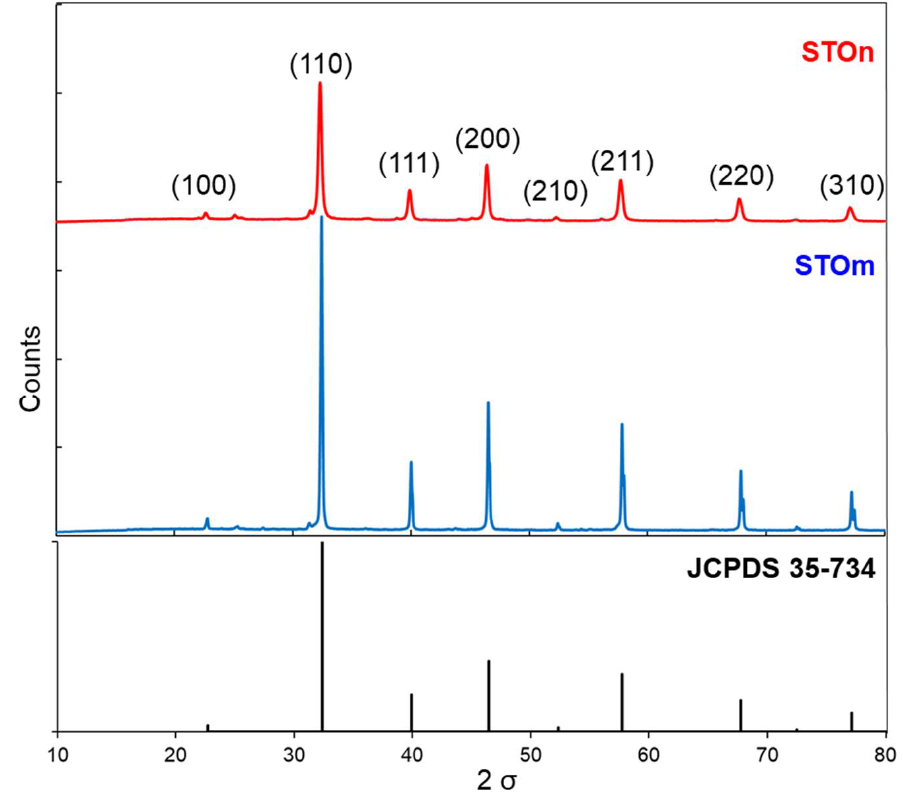
Figure 1. XRPD patterns of STOn and STOm (red and blue lines, respectively). As shown in Figure 1, their diffraction patterns fit to peak positions of the standard cubic perovskite structure (space group: Pm3m) of STO (JCPDS n. 35-734), whereas the other peaks can be attributed to traces of SrCO 3 (JCPDS 05-0418). Moreover, as expected, if compared to those of STOm, the diffraction peaks of STOn show weakened intensity which, coupled to the peak broadening, suggest smaller particle size, as furtherly confirmed by Scherrer equation: 98.3 nm and 30.5 nm for STOm and STOn, respectively. N 2 adsorption/desorption isotherms collected at −196 °C (Figure 2) are of Type IV, according to the IUPAC classification [60,61].